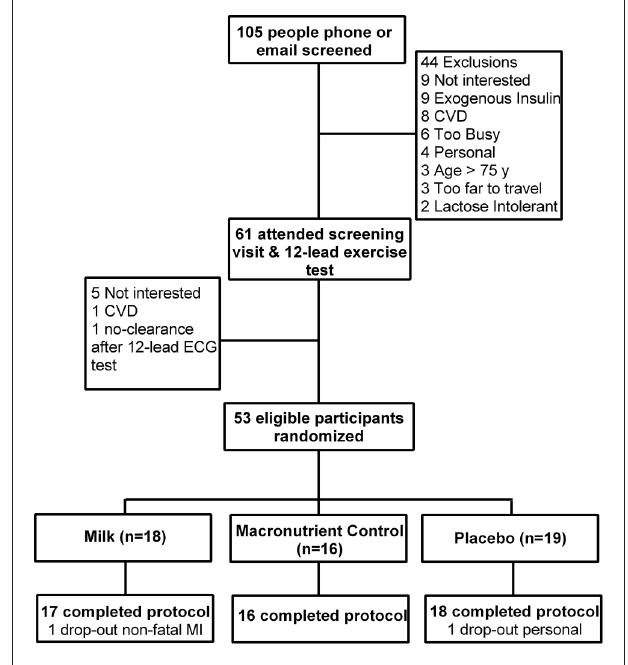
FIGURE 1 | Consolidated Standards of Reporting Trials (CONSORT) flow diagram.